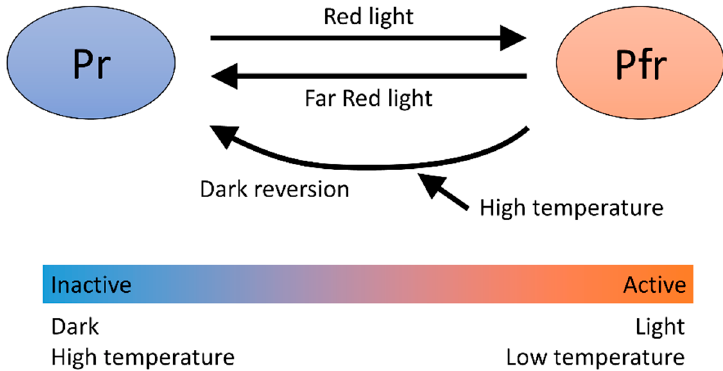
Figure 1. Light and temperature regulation of phyB activity. Phytochrome B state changes in response to light and temperature. It is activated by light, while it is inactivated in the dark and by high temperature through acceleration of dark reversion.